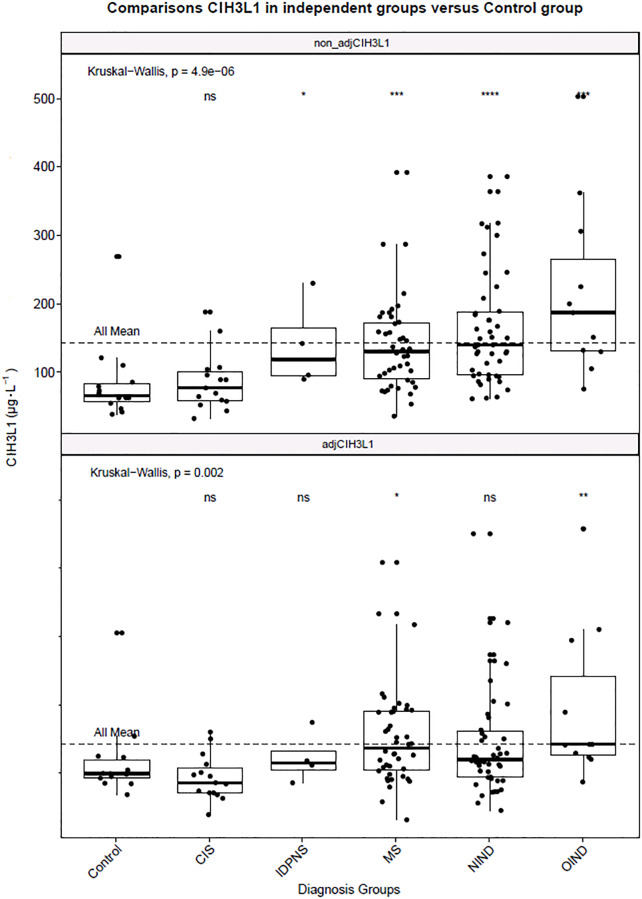
Box-plot concentration of CSF CHI3L1 individual diagnosis groups against base-mean CHI3L1 and results of pairwise comparisons between individual diagnosis groups against “control group”.Upper graph: non-adjusted levels of CHI3L1 Statistically significant differences were found in the IDPNS, MS, NIND and OIND groups. Lower graph: Age adjusted levels of CHI3L1. Statistically significant differences were found only in the MS and OIND group.